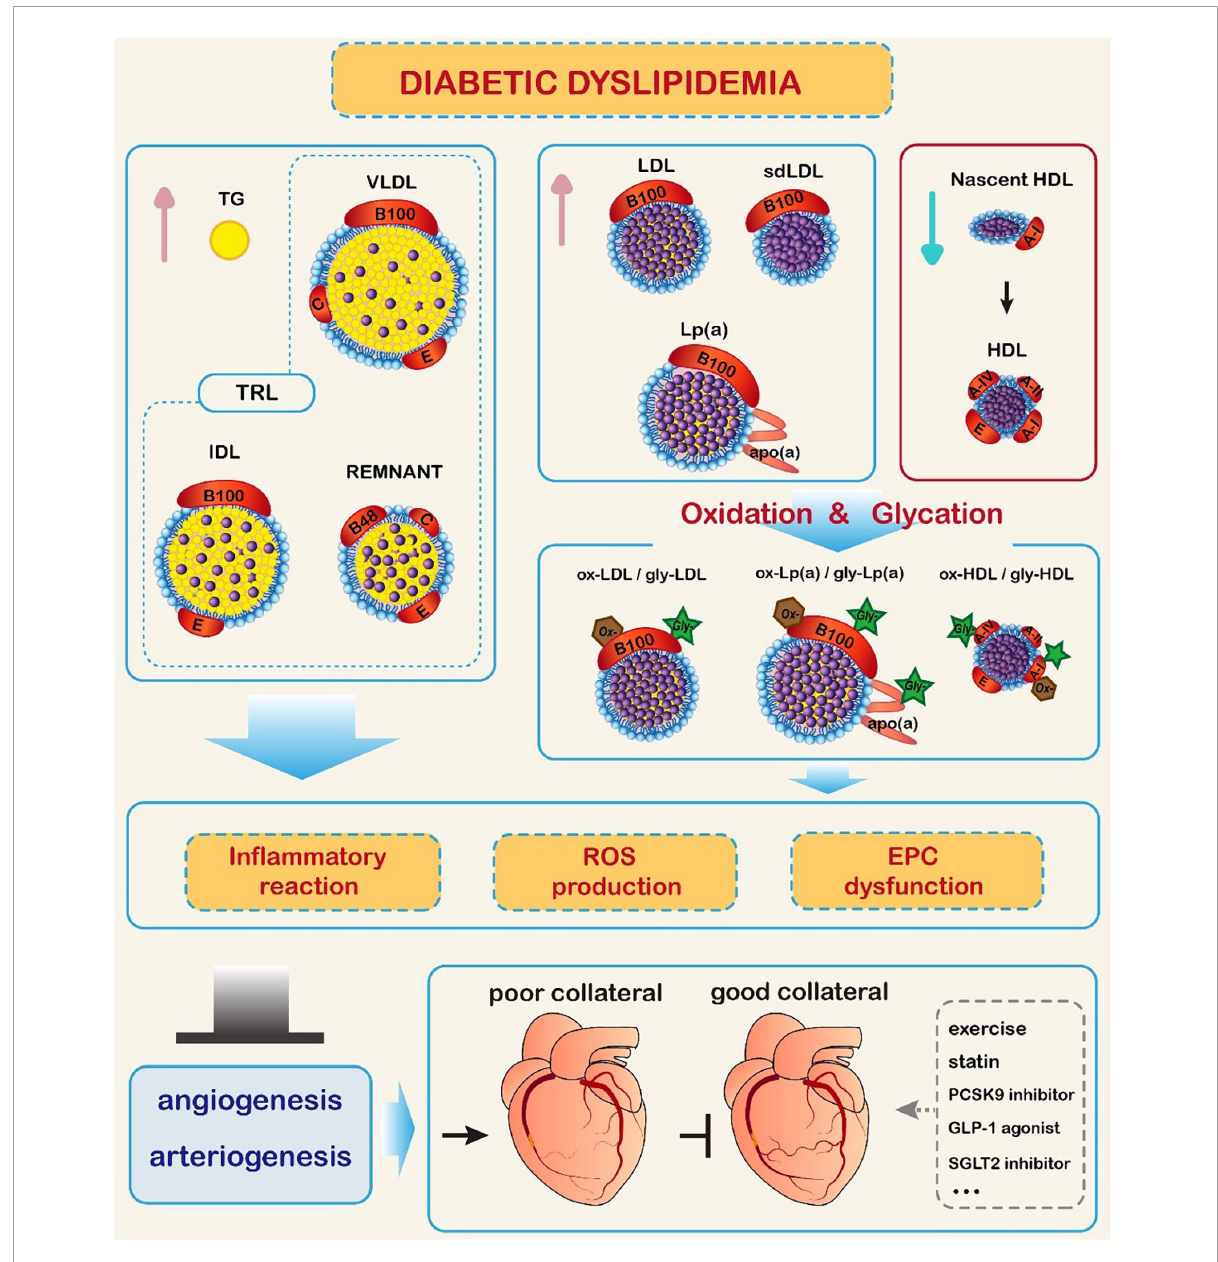
FIGURE1 Impact of diabetic dyslipidemia on coronary collateral formation. In diabetic conditions, triglyceride (TG) and TG-rich lipoproteins (TRL) levels are increased, high-density lipoprotein cholesterol (HDL-C) level is reduced, and low-density lipoprotein cholesterol (LDL-C) level is elevated with predominance of small dense LDL-C (sdLDL-C). Meanwhile, glycation and oxidative modification of lipoprotein particles occur, promoting inflammatory reaction, production of reactive oxide species (ROS), and endothelial progenitor cell (EPC) dysfunction. These changes hamper collateral formation through inhibiting the process of angiogenesis and arteriogenesis. Exercise, lipid-lowering therapy, and antidiabetic agents may improve coronary collateral formation. Represents cholesterol esters. GLP-1: glucagon-like peptide-1; IDL: intermediate density lipoprotein; Lp(a): lipoprotein (a); PCSK9: proprotein convertase subtilisin/kexin type 9; SGLT2: sodium-glucose cotransporter 2; VLDL: very low-density